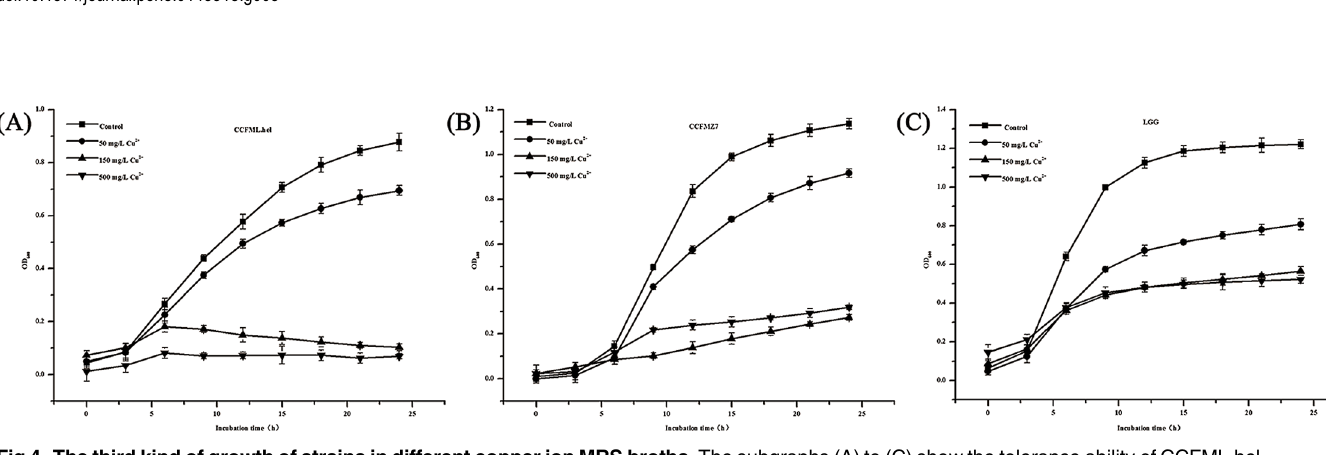
PLOS ONE | DOI:10.1371/journal.pone.0143318 November 25,